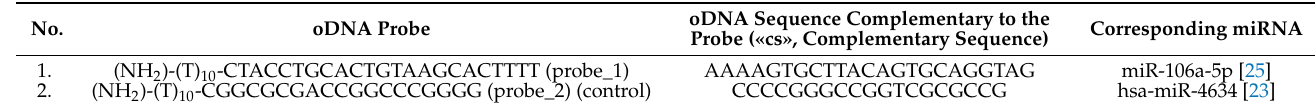
Table 1. Complements of oDNA and